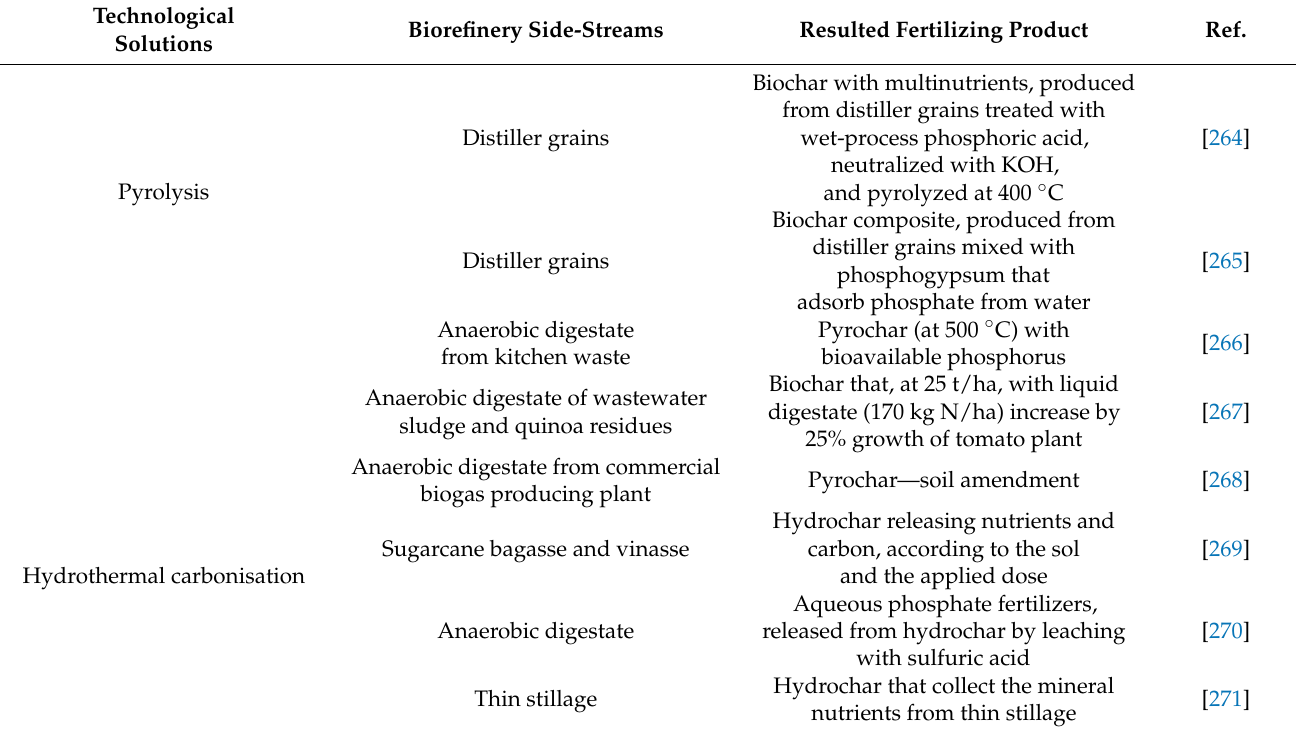
Table 3. Recovery of phosphorus, nitrogen, and sulfur and other nutrients from biorefinery side- streams.